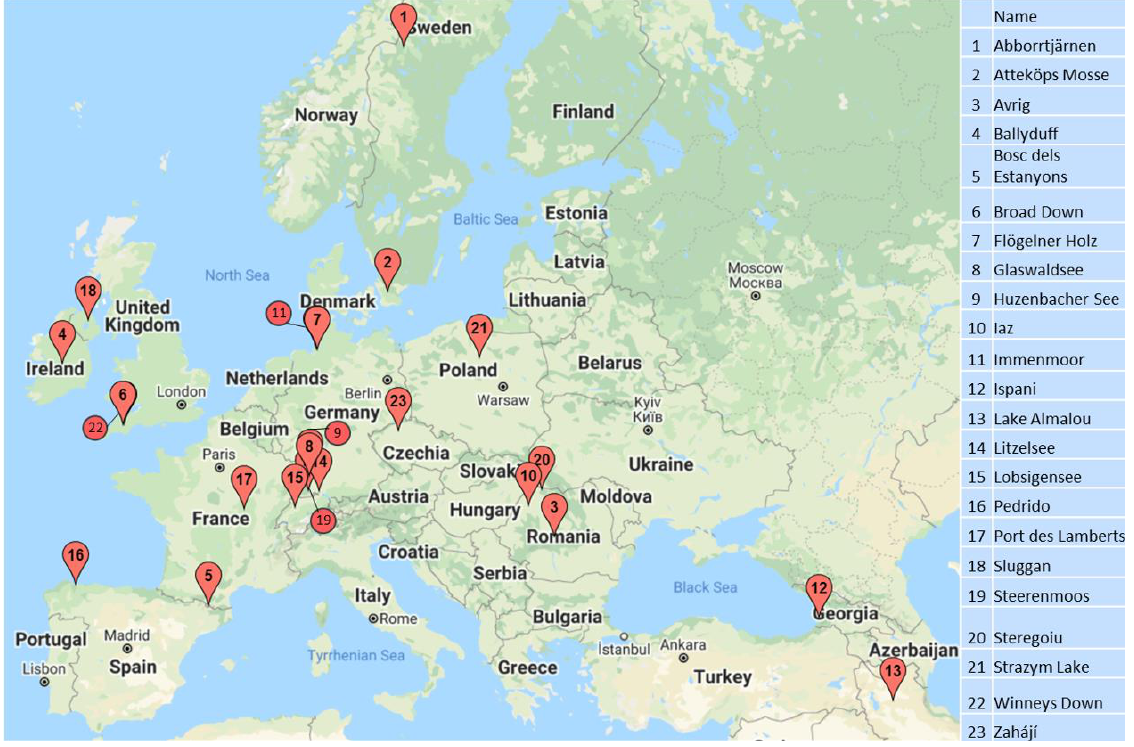
Figure 1. Sites included in this study. All palaeoecological data were collated from the European Pollen Database [44]; data are accessible as per the data accessibility statement at the end of this